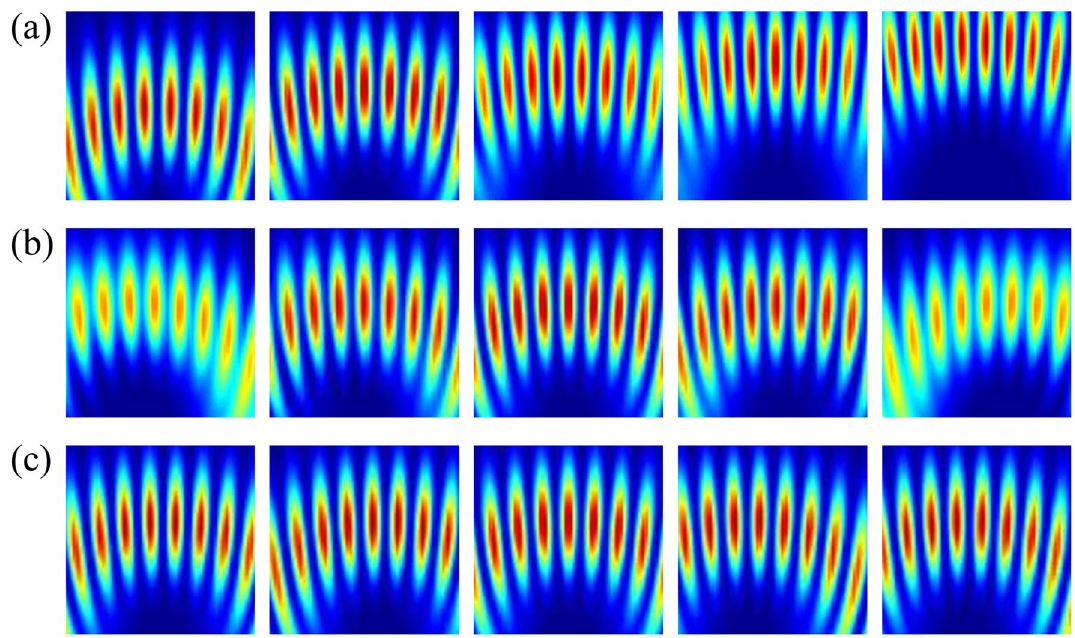
Figure 8. Experimentally detected holograms for vector vortex decoding are demonstrated. From left to right: ( a ) K increases from 2 to 6; ( b ) γ K = − π/3, − π/6, 0, π/6 and π/3 with K = 3; ( c ) χ K = − π/6, − π/12, 0, π/12 and π/6 with K = 3.